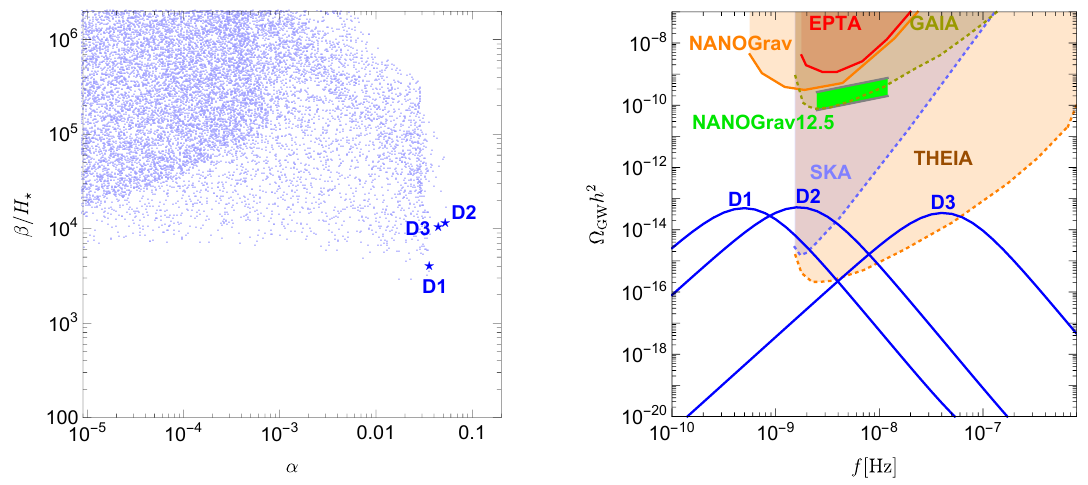
Figure 5 . Rethermalization scenario with r T = 0 . 6 and N 0 = 1 . Left panel: scatter plot in the ( α, β/H ) plane. Right panel: GW spectra for the three benchmark points in table 4 and marked ? with stars in the left